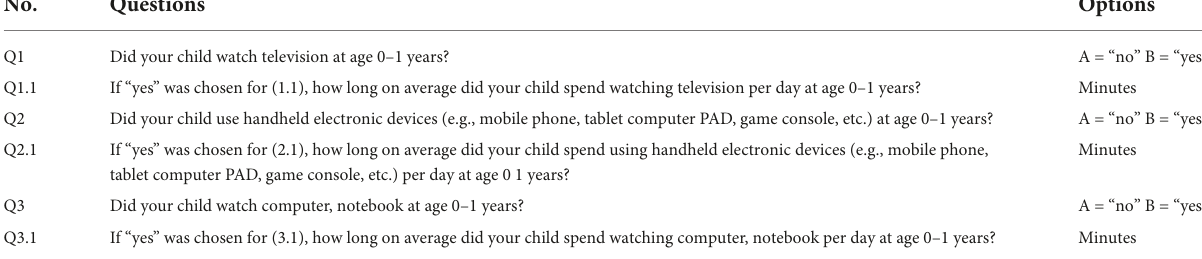
TABLE 1 Questions and options for screen exposure (0–1 years of age as an